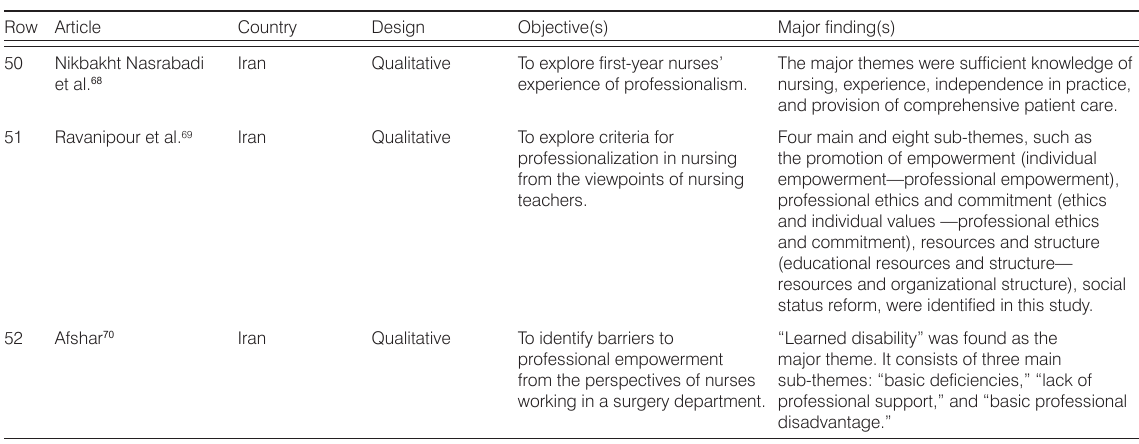
Table 1. Characteristics of the included